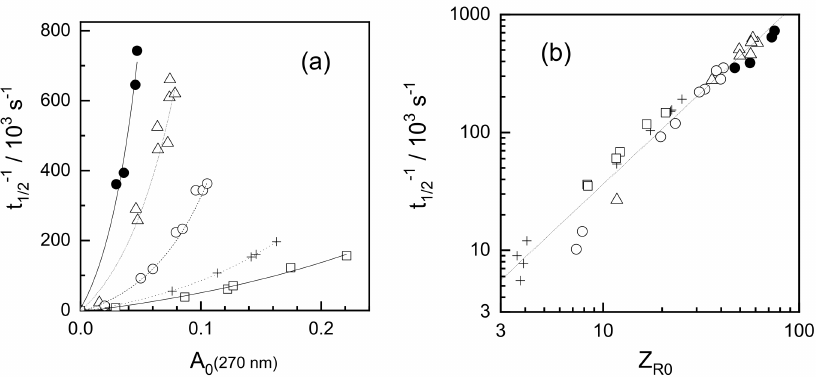
Figure 6. Pulse radiolysis of poly(ethylene oxide), M n = 218 kDa, in N 2 O-saturated aqueous solutions. PEO concentrations (in monomer units): 5.7 mM ( • ), 11 mM ( (cid:52) ), 23 mM ( 91 mM ( (cid:3) ). Rate of radical recombination (approximated as reverse half-life): ( a ) As a function of initial absorbance (proportional to the initial radical concentration); ( b ) As a function of the initial average number of radicals per chain ( Z R 0 ). Adapted with permission from [73]; published by Elsevier,